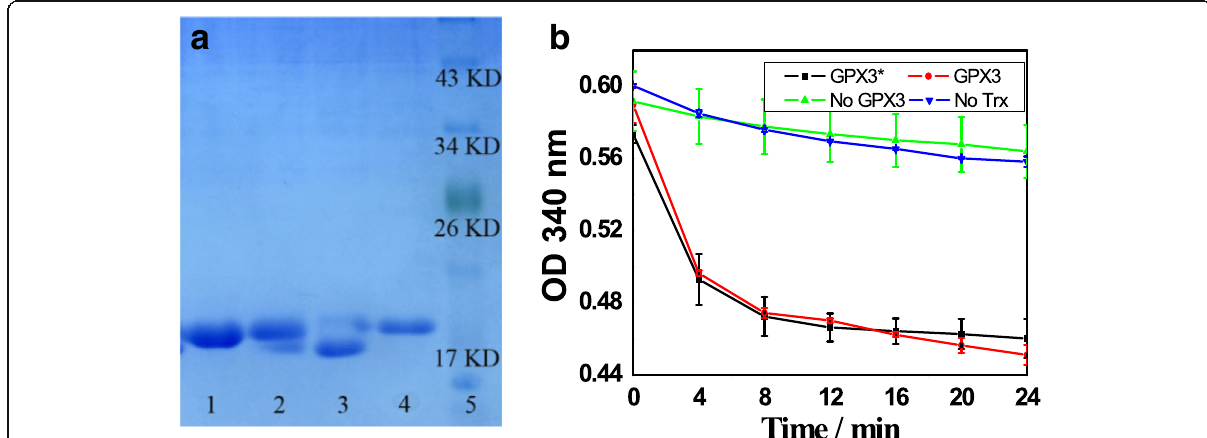
Fig. 6 a In vitro assays of GPX3 redox state: lanes 1 and 3 (the oxidized GPX3) and 2 and 4 (the reduced GPX3) refer to GPX3 obtained after the GST tag is cut off from Glutathione Sepharose 4B and SnO 2 /SiO 2 -GSH bound GST-tagged GPX3, respectively; lane 5, marker. b Assays of peroxidase activity of